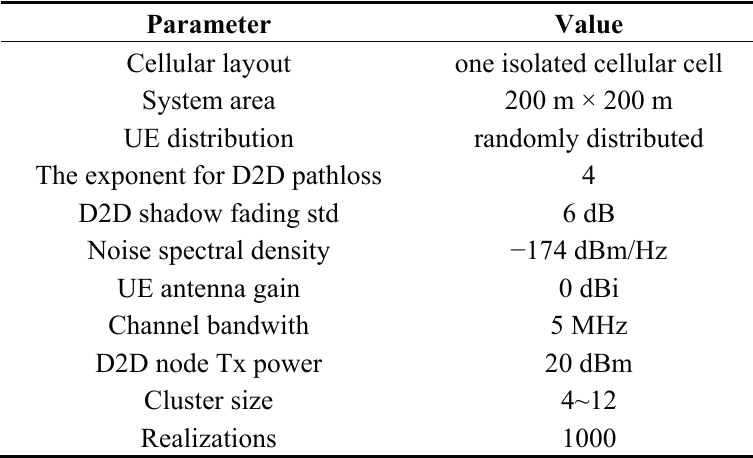
Table 1. Main simulation